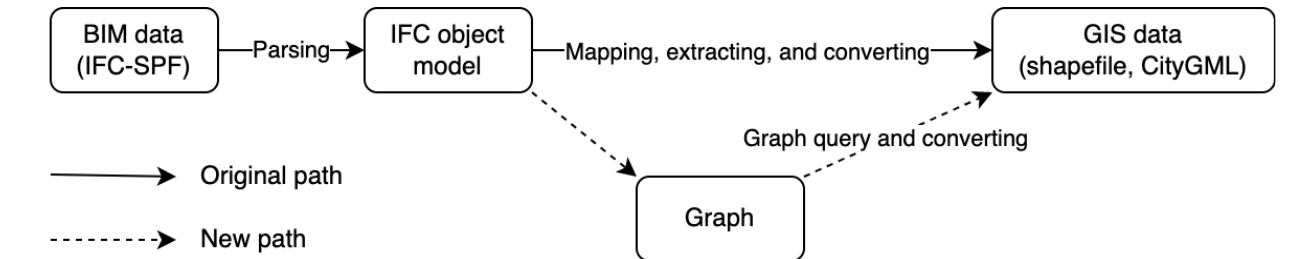
Figure 4. Graph contributing to BIM/GIS data integration.